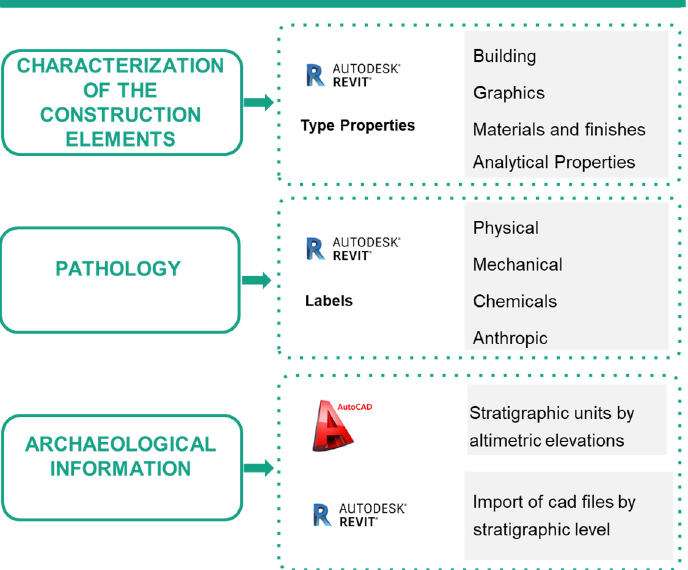
Figure 19. Diagram showing the type of qualitative information implemented in the parametric model and software used.